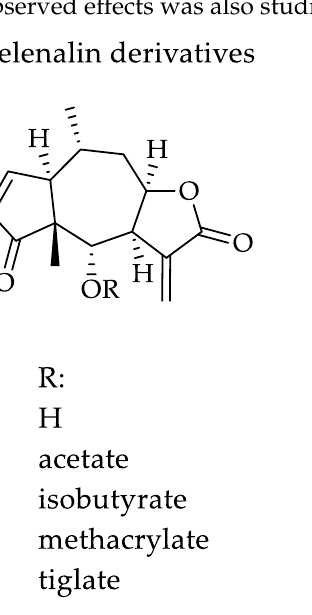
Figure 1. Chemical structures of the tested Arnica STLs.